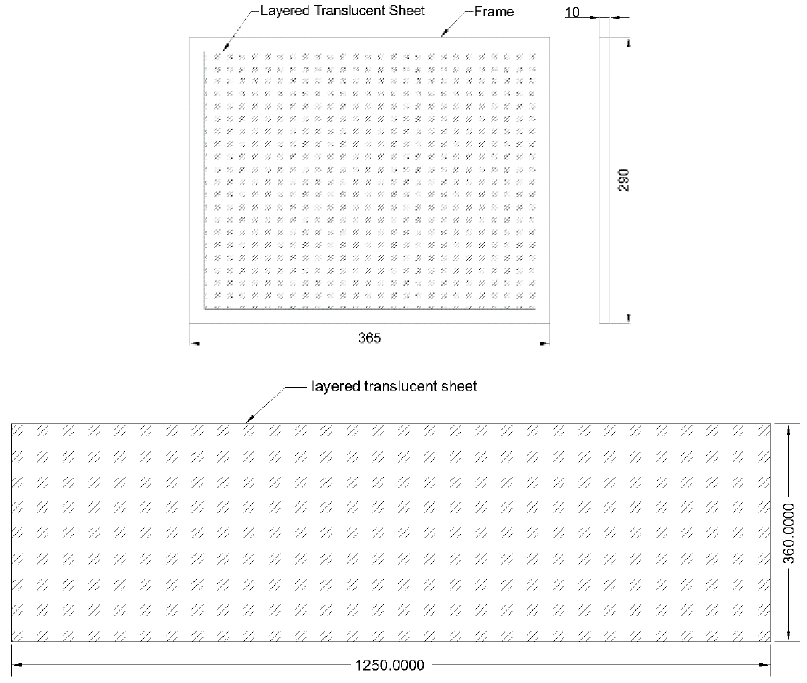
Figure 1. The screen (top one automotive set up, bottom one for aviation setup).